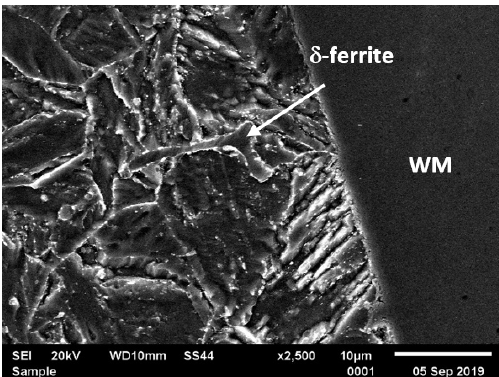
Figure 7. The δ -ferrite in the vicinity of the fusion line—CGHAZ, joint No. 2; WM—weld metal.